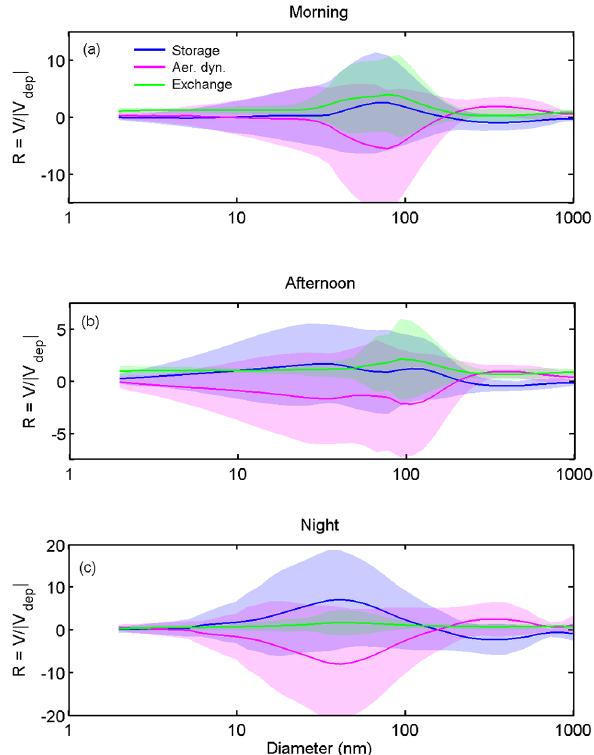
Figure 10. Variation of change velocities with particle size for (a) morning (from sunrise until noon), (b) afternoon (from noon until sunset) and (c) night (sun below horizon) periods: the blue line indicates the storage, magenta the aerosol dynamics and green the vertical exchange velocities. The lines present the ratios of the average change velocities to the average deposition term according (cid:104) V (cid:105) to (cid:10)(cid:12) (cid:12) (cid:12)(cid:11) obtained from model simulations for each 10min period (cid:12) V dep and the shaded areas are the variation range as ± σ V (cid:10)(cid:12) averages.